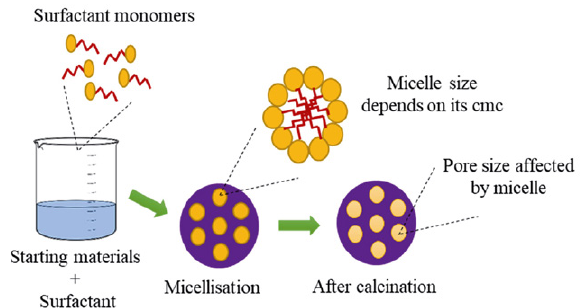
Fig. 2. The general illustration of micellisation of surfactants during